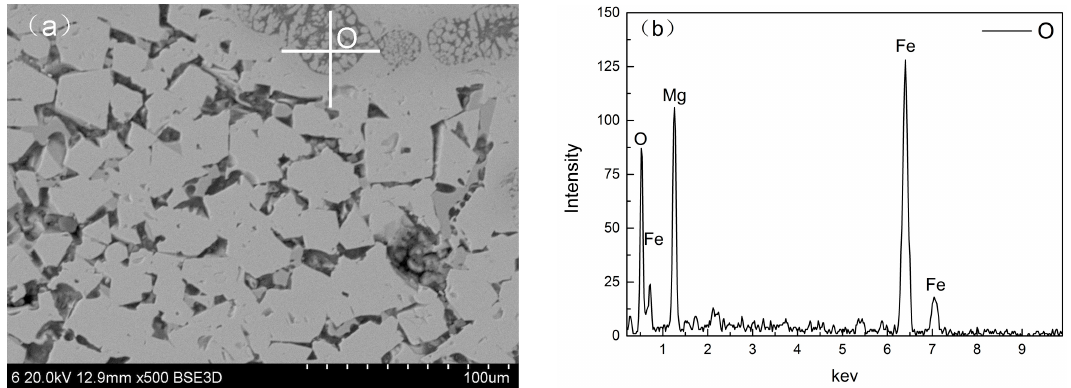
Figure 9. Spheroidal crystal of the magnesium ferrite ( ω (MgO) = 3.86%): ( a ) SEM micrographs; ( b ) EDS of point O.